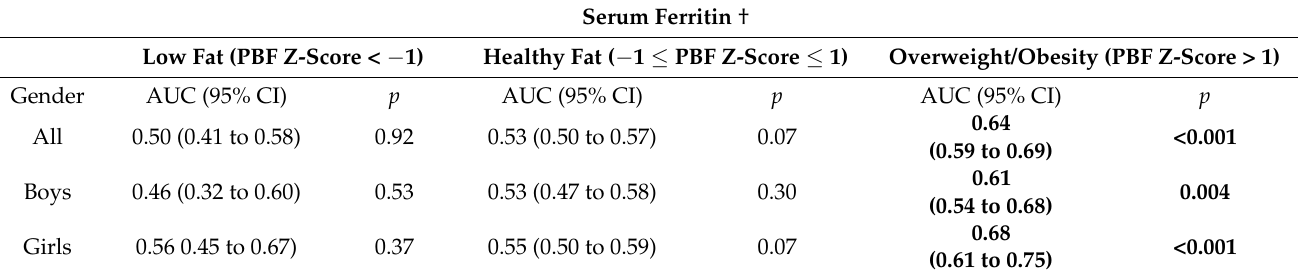
Table 2. Performance of serum ferritin in predicting dyslipidemia among participants with different PBF categories.